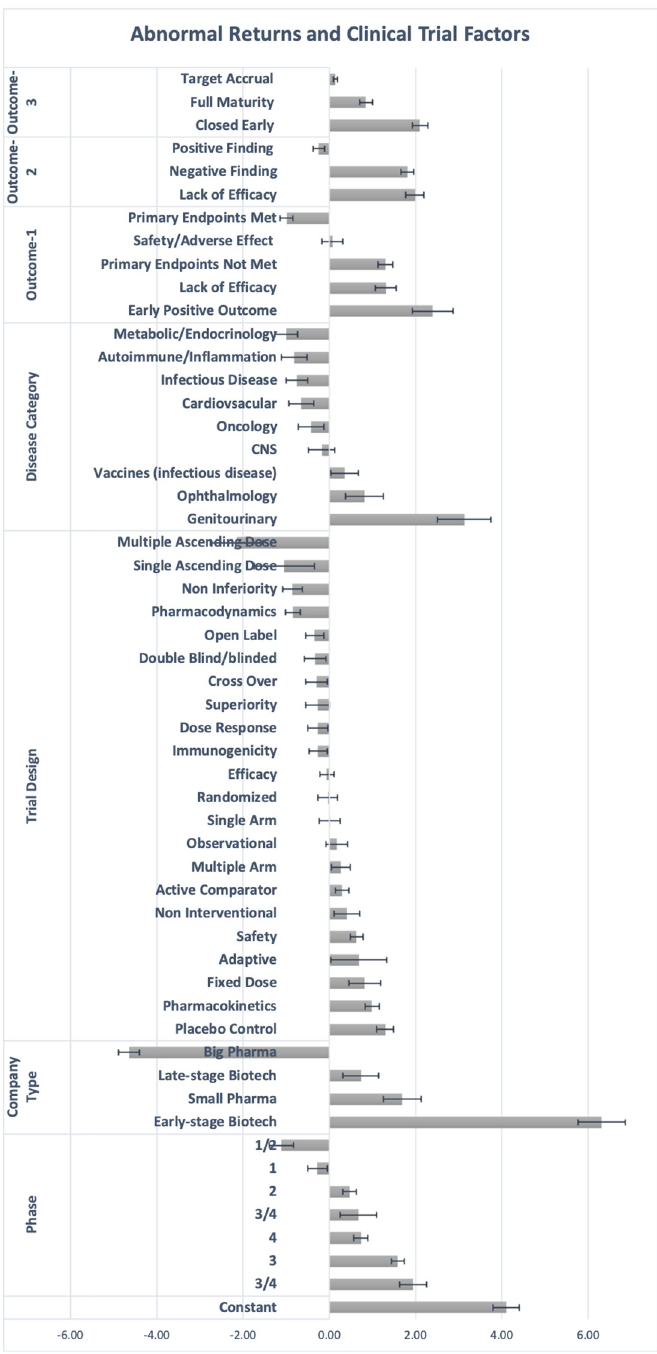
Fig 6. This bar plot presents the relative abnormal returns due to different clinical trial and sponsor company factors on the day of event (day 0–1). These abnormal returns are obtained from the regression coefficients using Eq (1) on the day of event (day 0 and day 1). The x-axis is in percentage points and the 95% confidence intervals are plotted on the bar plots.